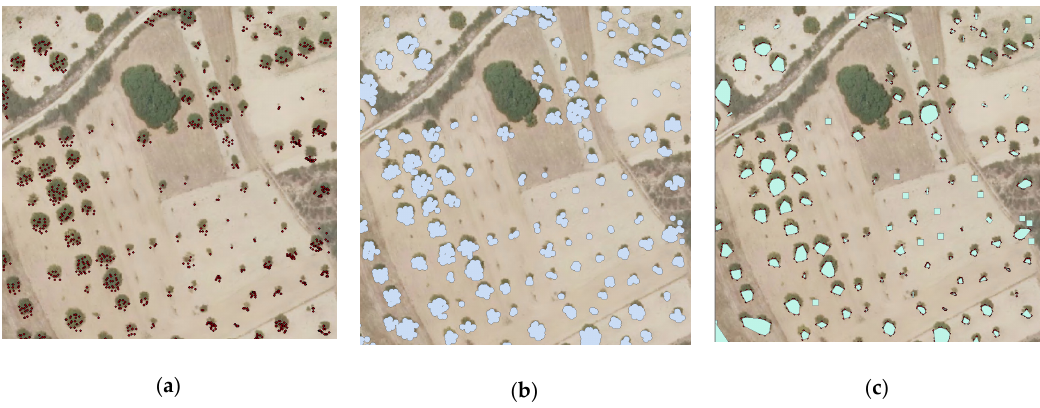
Figure 11. Steps followed in two-dimensional (2D) crown shape delineation: ( a ) orthogonal projection of canopy returns. ( b ) Creation of buffer to cluster points into individual trees. ( c ) Convex hull and tree crown shape delineation. Reference image: PNOA image [56].